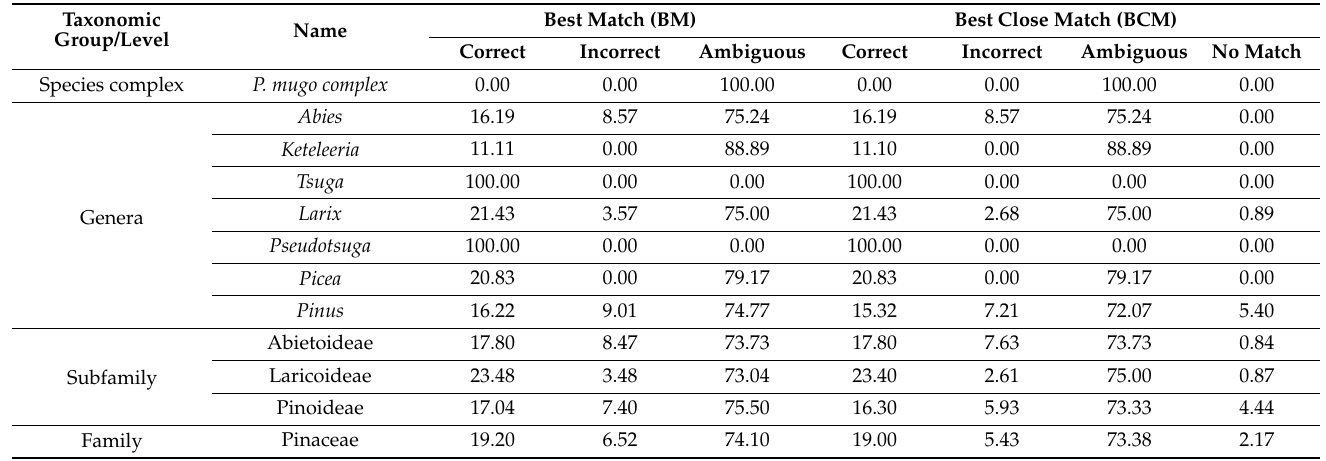
Table 3. Percentage of correct, incorrect and ambiguous sequence identifications based on the ‘best match’ and ‘best close match’ with TaxonDNA